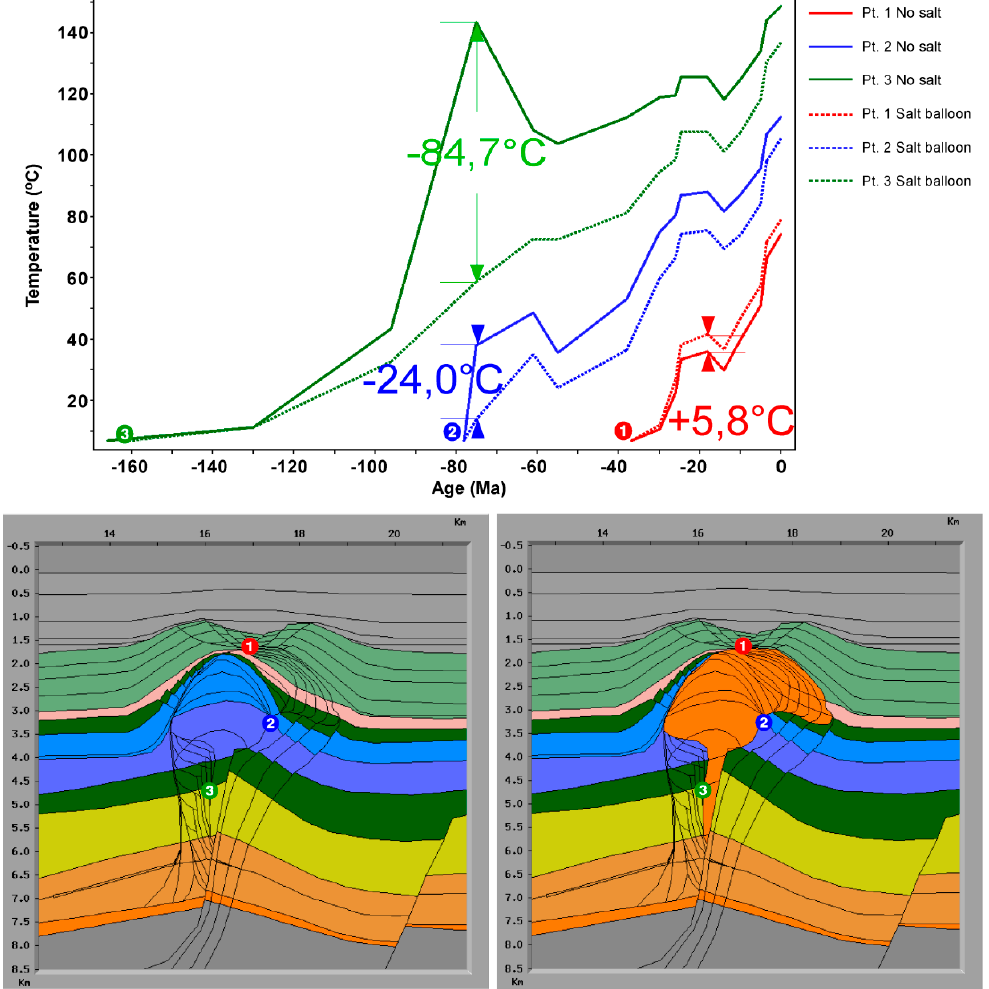
Figure 17. Temperature history difference in models with and without the growth of a salt balloon structure. The curves show temperature history of the points 1, 2, and 3 given on the two model profiles. The temperature of point 1 above the salt increases by 5.8 °C in the salt balloon model, whereas the lowest point below salt shows a decrease of more than 84 °C in salt model.